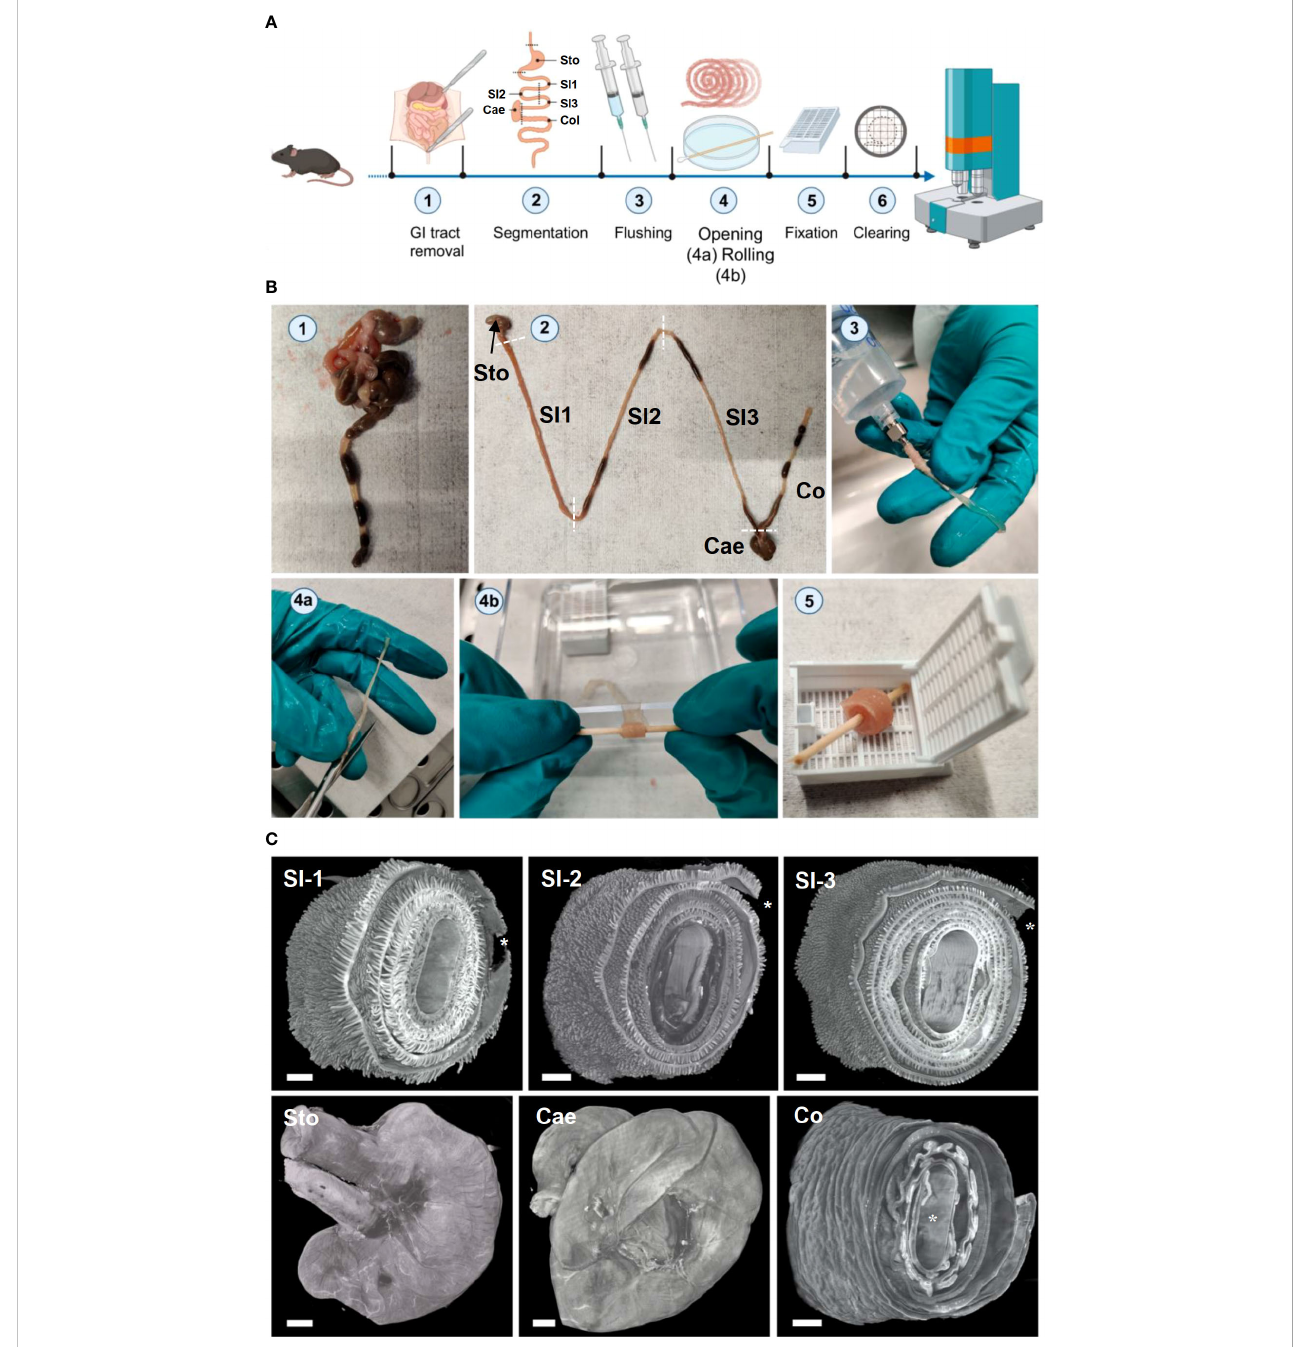
FIGURE 2 3D-Swiss Rolls sample preparation procedure for LSFM imaging enables holistic assessment of the entire GIT. (A) Schematic and (B) photographic representation of the 3D-Swiss Rolls work fl ow. (1) After euthanasia the lower GIT is disconnected from the body by incisions at the esophagus and rectum and removed entirely. (2) Six specimens are created by cutting as indicated by dashed lines: stomach (STO), three segments of the small intestine (SI 1-3), cecum (CAE) and colon (COL). (3) Each specimen is cleaned by fl ushing out chyme and feces with PBS PC and then immediately fi lled with NBF for fi xation. (4a) SI and COL segments are cut open along the mesenteric line and (4b) rolled up on wooden sticks to create 3D-Swiss Rolls. (5) The created 3D-Swiss Rolls are then fi xed without touching the surfaces of the histology cassette for 14-18 h in NBF at 4°C. After fi xation, 3D-Swiss Rolls are unwound and re-rolled on plastic stirring rods for dehydration and clearing (not shown). (C) Surface rendering of LSFM image stacks of the tissue auto fl uorescence (545 ! 595 nm, grey). 3D-Swiss Roll segments of the small intestine (SI1-3) and colon (Col). Stomach (Sto) and cecum (Cae) retained their physiological form. *Proximal end of the organ in 3D-Swiss Rolls. Scale bars = 1